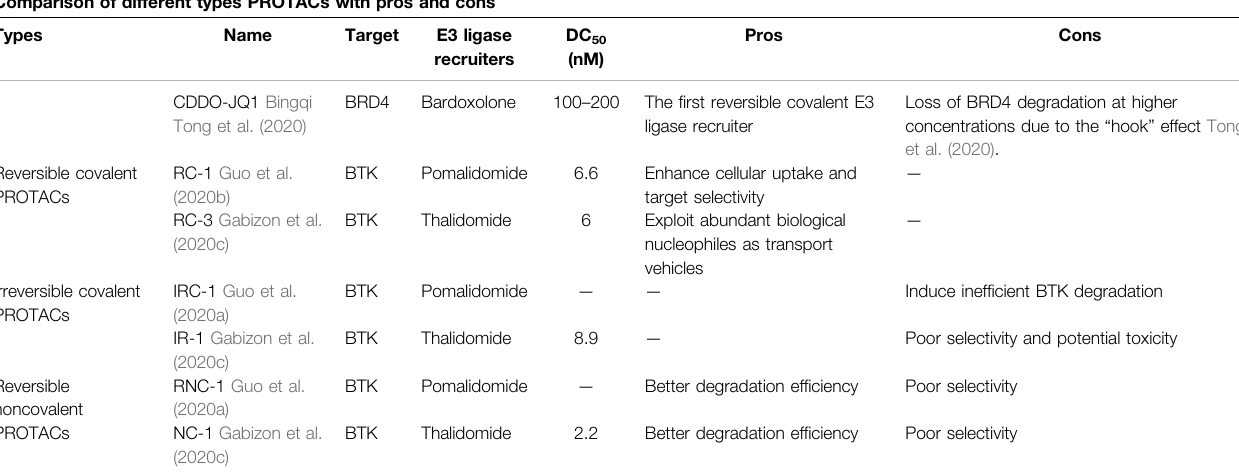
TABLE 1 | Comparison of different types PROTACs with pros and cons. Comparison of different types PROTACs with pros and